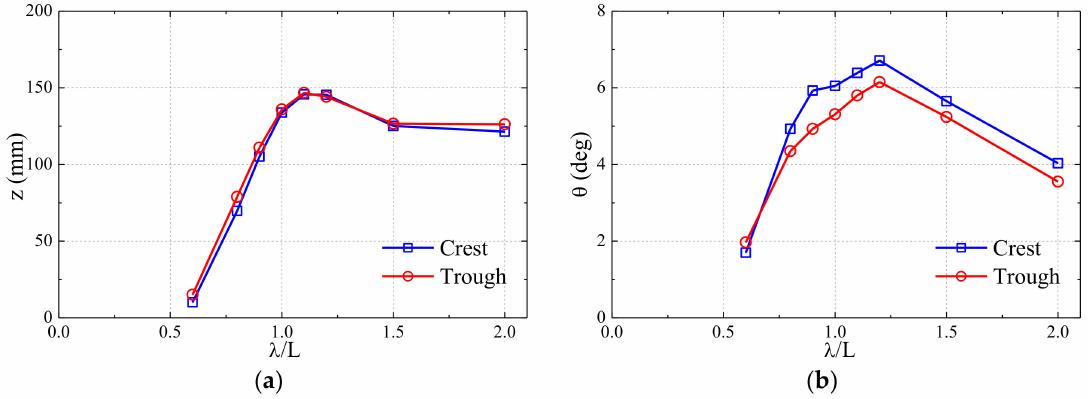
Figure 22. Ship vertical motion amplitude value at di ff erent wave lengths: ( a ) heave; ( b ) pitch. The green water on deck phenomenon for ship sailing in the wave heading 45 typical wave lengths of λ / L = 0.8, 1.2, 1.5, and 2.0 is compared in Figure 23. The figures reveal that the